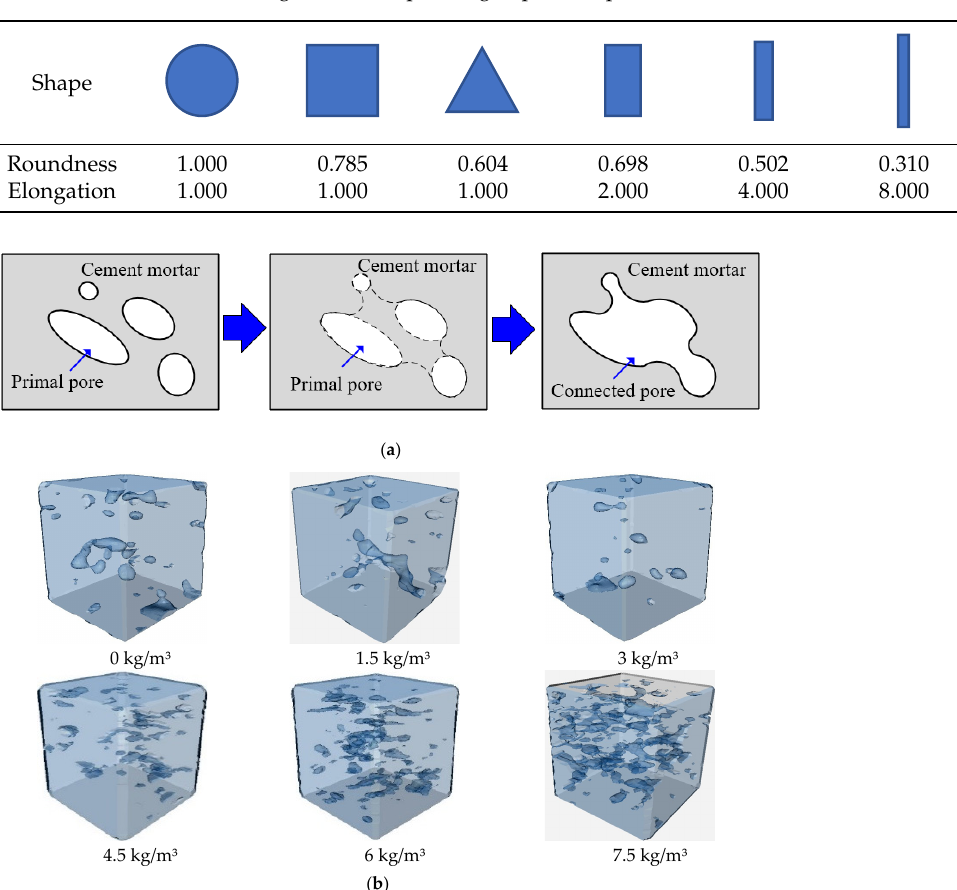
Figure 14. Three-dimensional reconstitution of internal pores of samples with different BF content ratios. ( a ) Primal pore penetration process; ( b ) Pore distribution. ratios. ( a ) Primal pore penetration process; ( b ) Pore